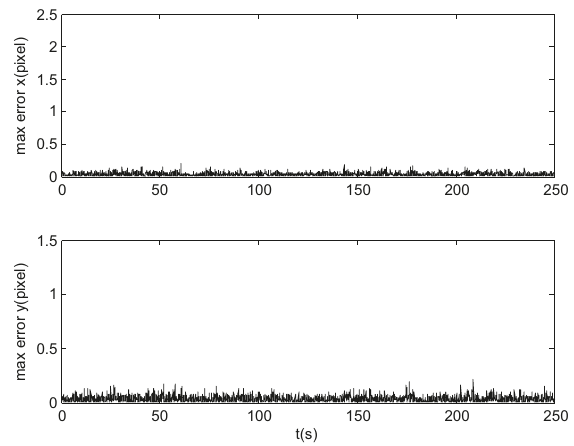
Figure 10. Maximum prediction error of the star locations in simulation.